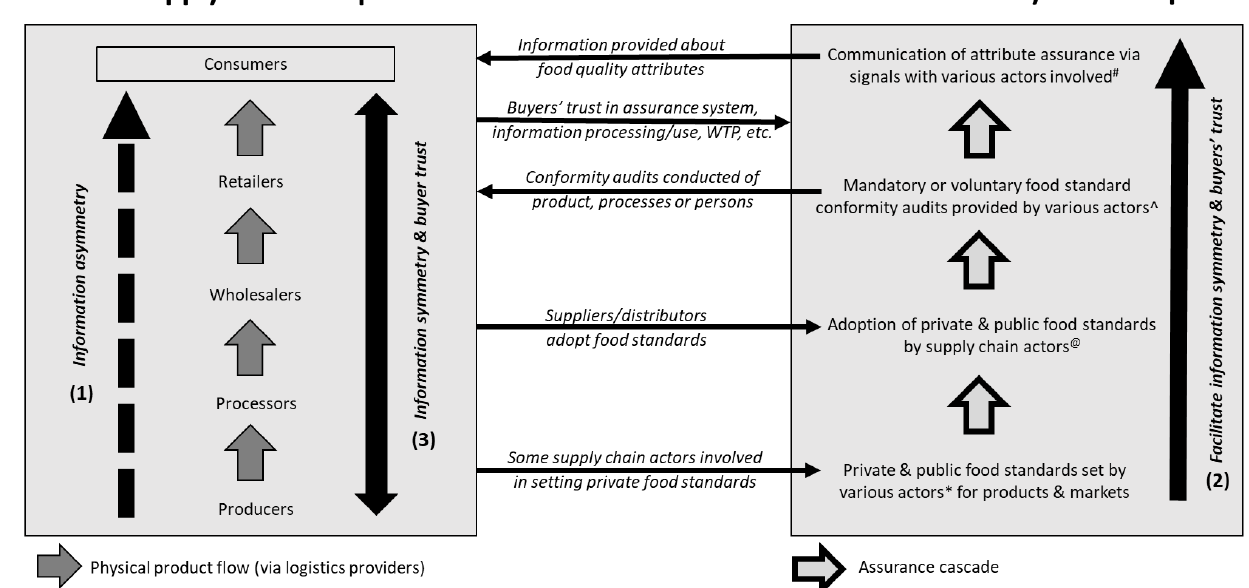
Figure 2. Conceptual framework of stakeholders and mechanisms to address information asymmetry in the market for food credence attributes. Notes: (1)–(3) indicates the sequence of action in addressing information asymmetry among supply chain actors. * Actors involved in private and public standard settings include the government, private supply chain stakeholders, e.g., producer organizations, retailers, non-governmental organizations. @ All supply chain stakeholder groups, except consumers, mandated to adopt food standards (i.e., public standards) or can opt to adopt private standards. ^ Certification providers can include first parties (e.g., producer who issue food quality guarantees), second parties (e.g., retailer guarantees), and third parties (e.g., independent private or governments actors which undertake conformity audits and provide certification). # Communication of credence attributes through signals such as product labels includes producers, processors, retailers, and certification providers. Source: Authors’ summary based on the literature review.